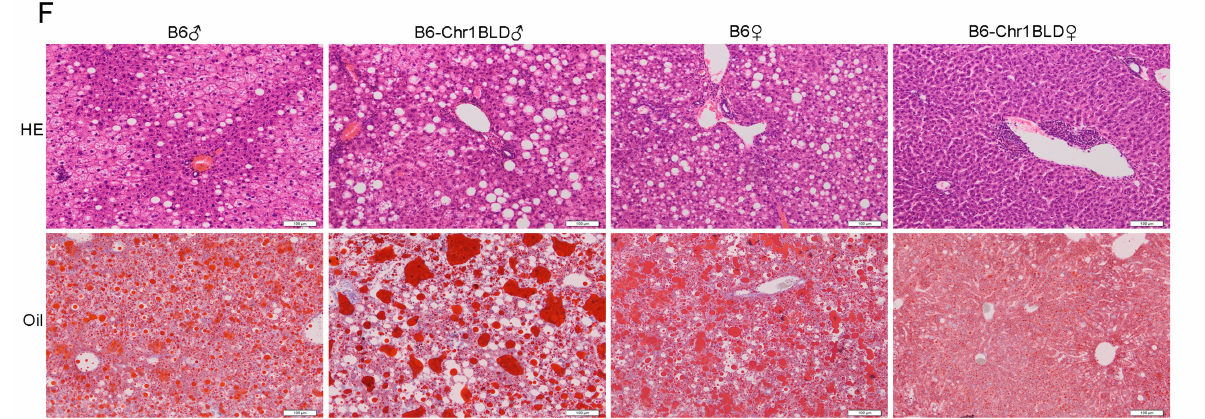
Figure 4. HFD-fed B6-Chr1BLD line showed significant abnormalities in body weight, lipid metabolism and liver lesions. ( A ) Average body weight trajectory in HFD-fed male mice ( n = 5 per group). ( B ) Average body weight trajectory in HFD-fed female mice ( n = 5 per group). ( C ) The serum lipid levels (CHO, TG, HDL-C, and LDL-C) of 20-week-old C57BL/6J and B6-Chr1BLD mice (HFD fed for 12 weeks) ( n = 5 per group). ( D ) The serum lipid levels (CHO, TG, HDL-C, and LDL-C) of 23-week-old C57BL/6J and B6-Chr1BLD mice (HFD fed for 15 weeks) ( n = 5 per group). ( E ) The representative H&E and Oil Red O staining in liver sections of 34-week-old C57BL/6J and B6-Chr1BLD mice (HFD fed for 26 weeks). Scale bars (H&E staining) = 100 µ m. Scale bars (Oil Red O staining) = 50 µ